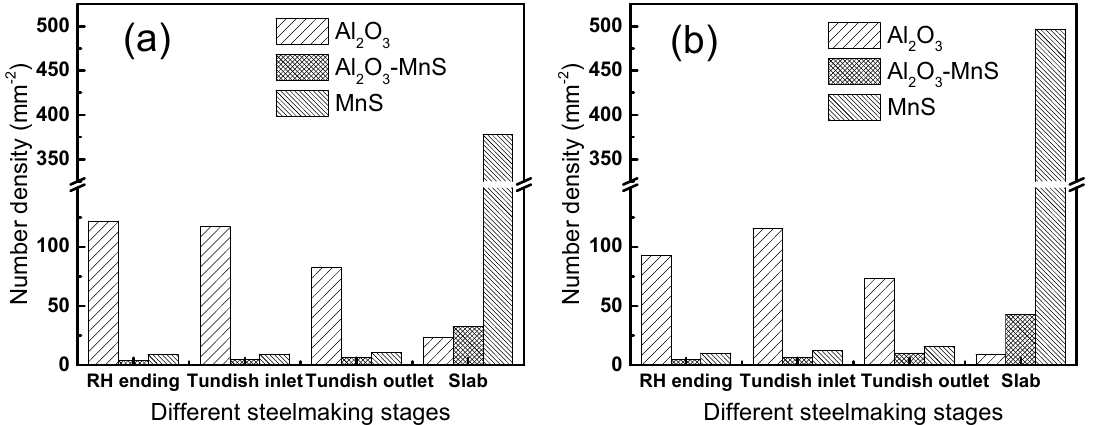
Figure 3. Number density of different inclusions at different steelmaking stages for ( a ) Steel A and ( b ) Steel B.